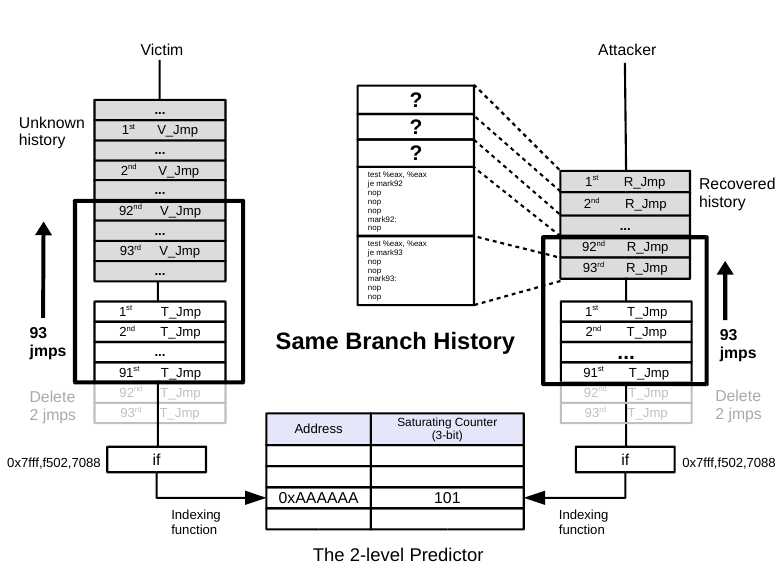
Figure 6: Recovering the branch history when 2 branches in the victim process have been recovered. The grey block in the victim program is the branch history the attacker needs to recover, and the grey block in the attacker program is the history result